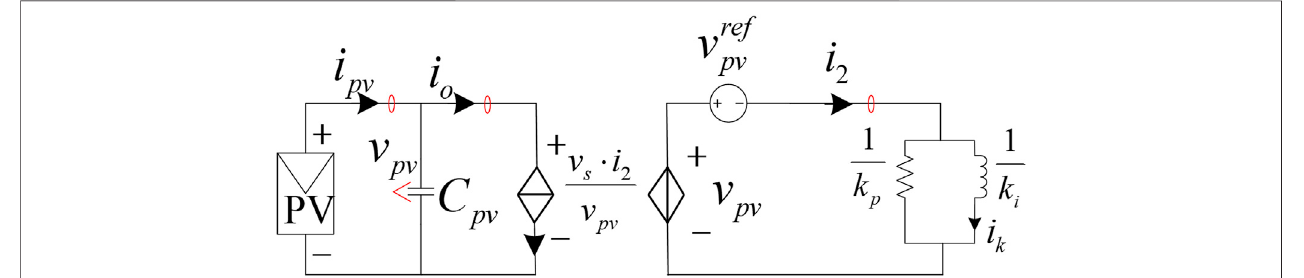
FIGURE 3 | Equivalent topology when analyzing the transient stability.